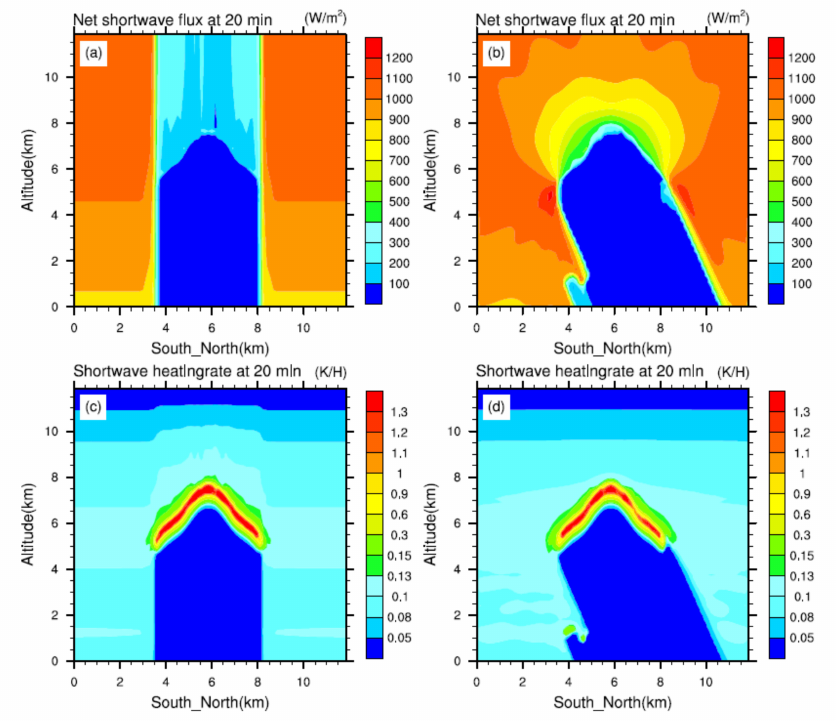
Figure 9. Net shortwave radiation flux and Shortwave heating rate in the 1D radiation case ( a , c ) and the 3D radiation case ( b , d